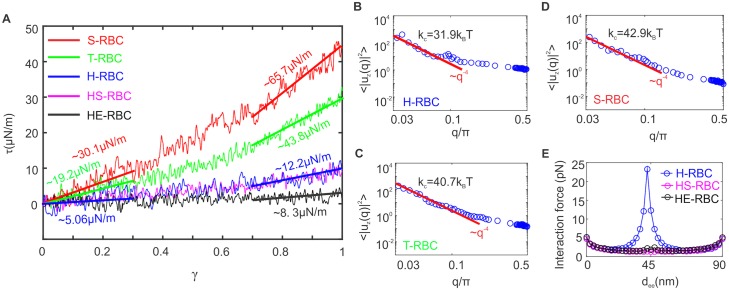
Biomechanical properties obtained from two-component composite CGMD model.(A) Shear response of the healthy and diseased RBC membranes. (B)-(D) show the vertical displacement fluctuation spectra of healthy and diseased RBC membranes as a function of wave number q. (E) Measured bilayer-cytoskeleton interaction force at different end-to-end distance between two actin junctions, dee, for healthy and defective RBCs.